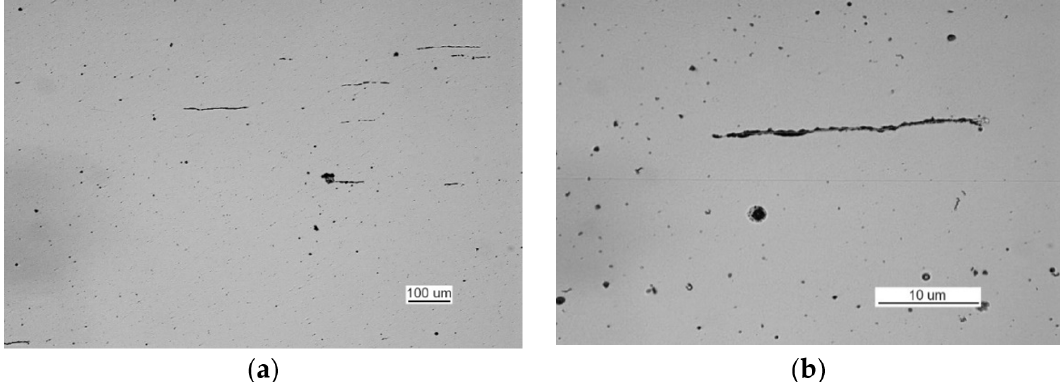
Figure 24. Optical microscopy views (handy-size bulk carrier 30206 DWT): ( a ) numerous rolled-out sulfides and oxide spots and ( b ) rolled-out manganese and iron sulfides with adjacent silicates and numerous oxide spots.